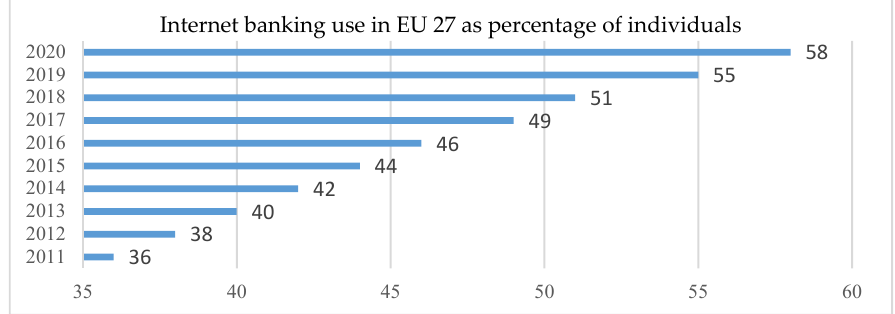
Figure 6. Internet banking—EU 27. Source: Authors projection using Eurostat database. Data extracted on 12 September 2021 online data code: TIN00099.